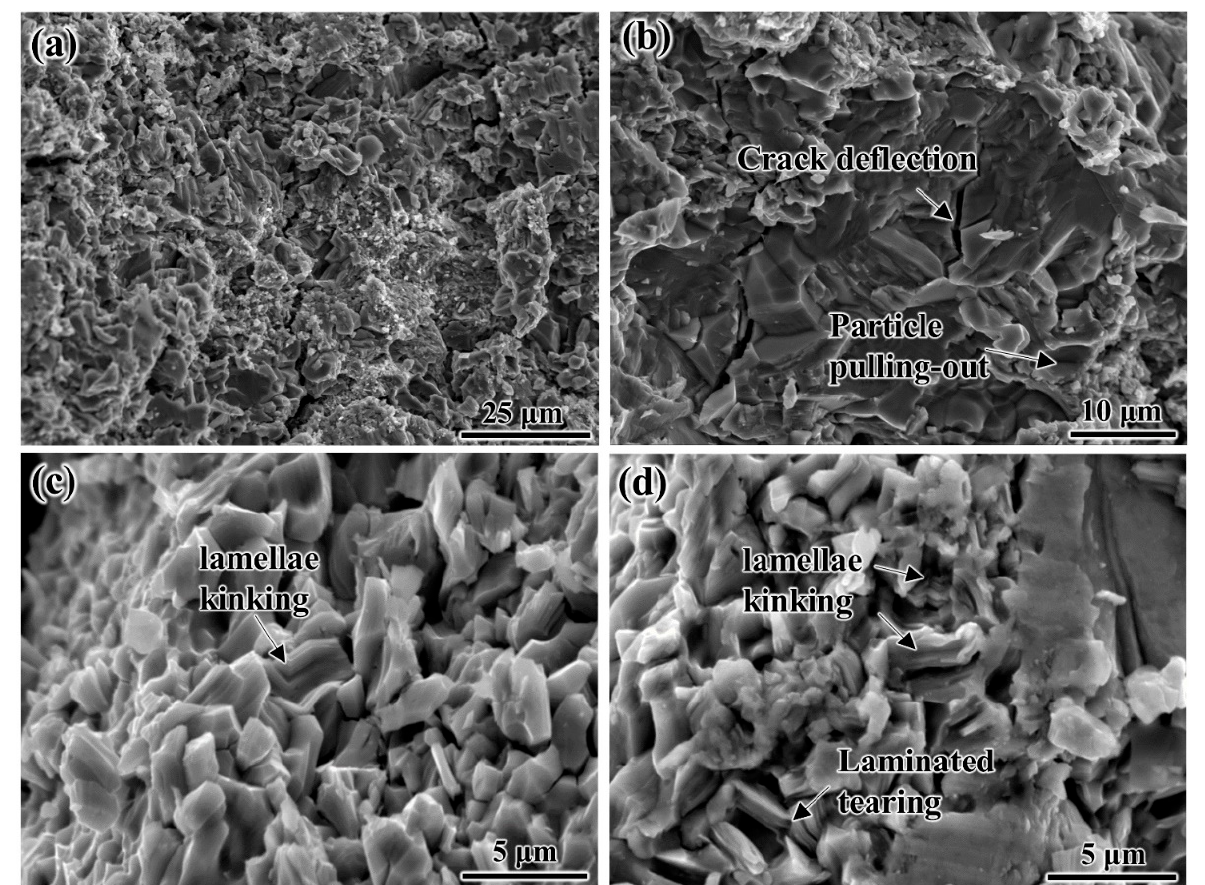
Figure 8. SEM images of fracture morphologies in as-prepared Ti 2 AlC/TiAl composite: ( a ) fracture morphology; ( b ) crack deflection and particle pulling-out; ( c ) lamellae kinking; ( d ) laminated tear- ing.